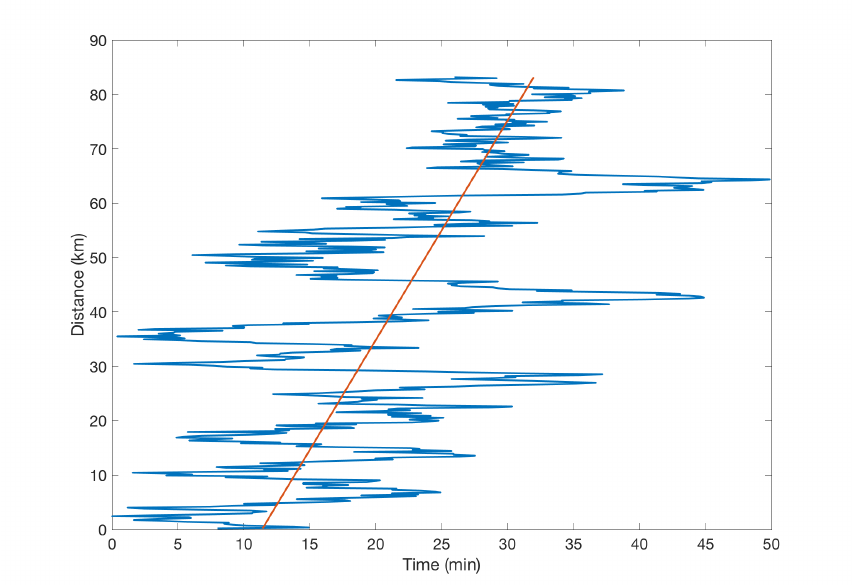
Figure 7. Temporal phase evolution of the 150 min wave extracted from the east–west keogram; the red line is the linear fit.